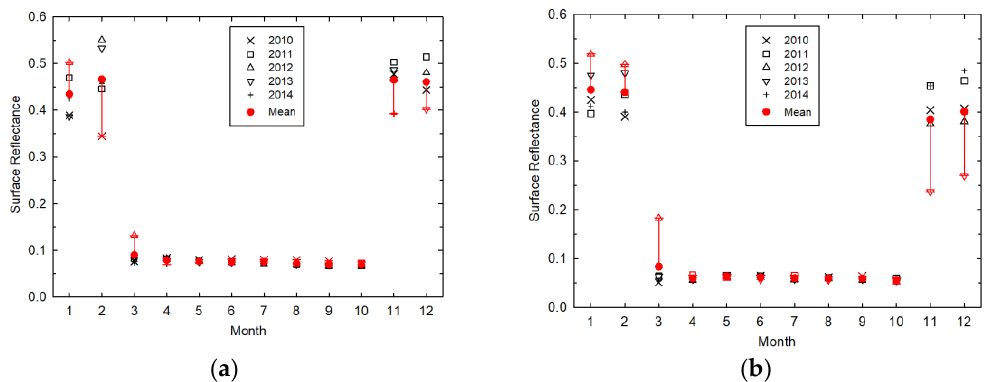
Figure 9. The variation of surface reflectance during the same month in different years near the ground sites. ( a ) Dahuangshan; ( b ) Wucaiwan. The error bars represent the maximum absolute error compared with the average value for 5 years.